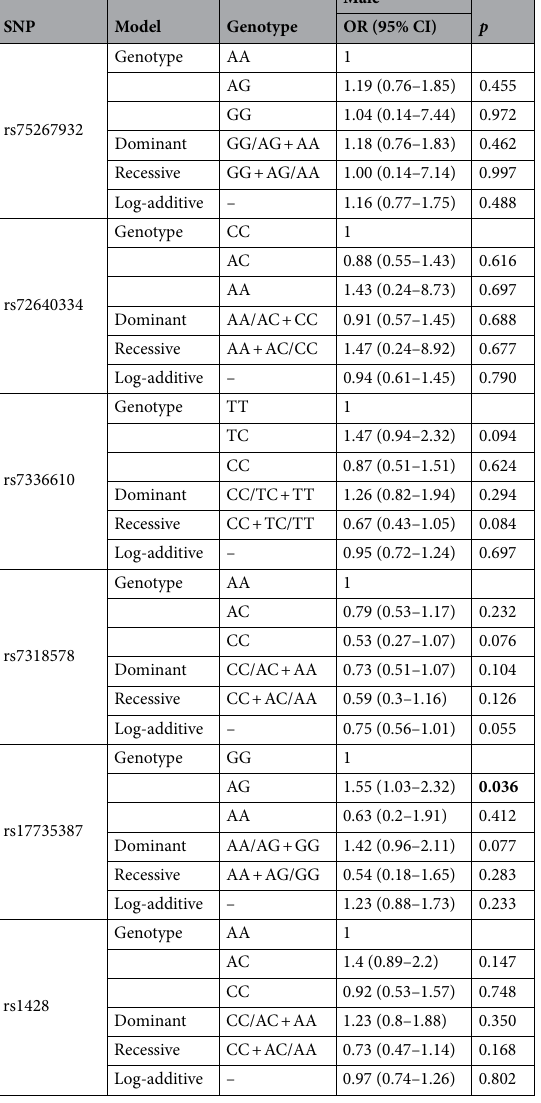
Table 4. Stratification analysis by gender for the effect of MIR17HG SNPs on HAPE risk. SNP single nucleotide polymorphism, OR odds ratio, 95% CI 95% confidence interval. Bold indicated that p < 0.05 meant the data was statistically significant.